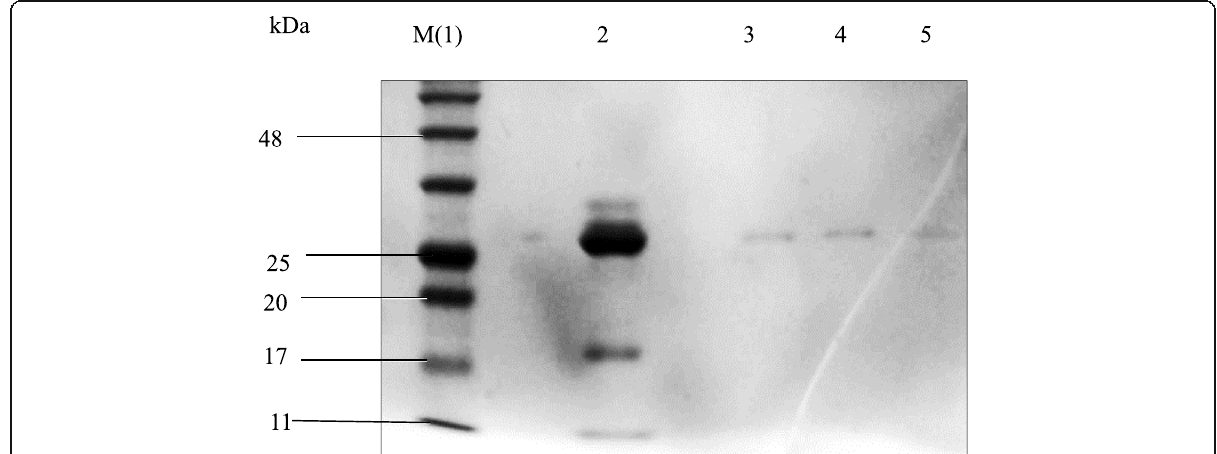
Fig. 15 Purification of A. mylitta native cocoonase and its SDS-PAGE separation. Twelve percentage SDS-PAGE analysis showing 25 – 26 kDa cocoonase purified using Sephadex G25 column. Lane 1 (M) showing prestained protein marker of Himedia; lane 2 showing collected crude cocoonase, and lanes 3, 4, and 5 showing the purified cocoonase obtained in different